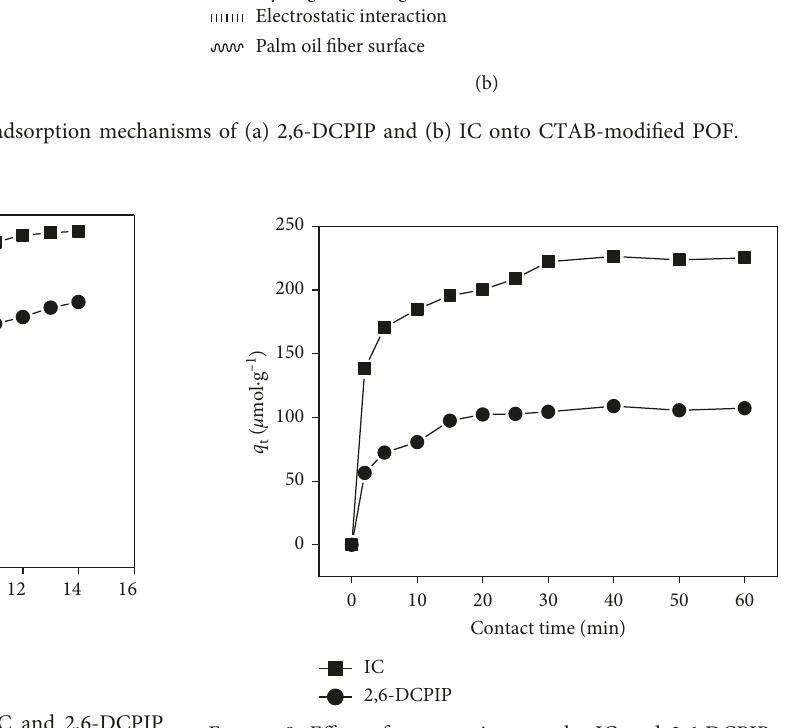
Figure 8: Effect of contact time on the IC and 2,6-DCPIP ad-